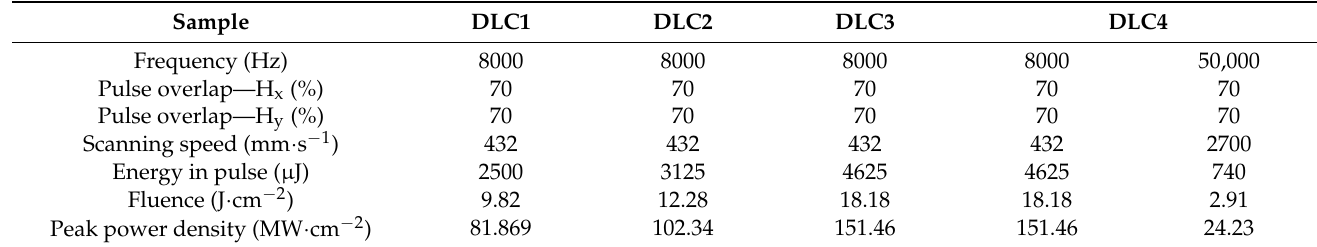
Table 5. DLC C coating laser stripping